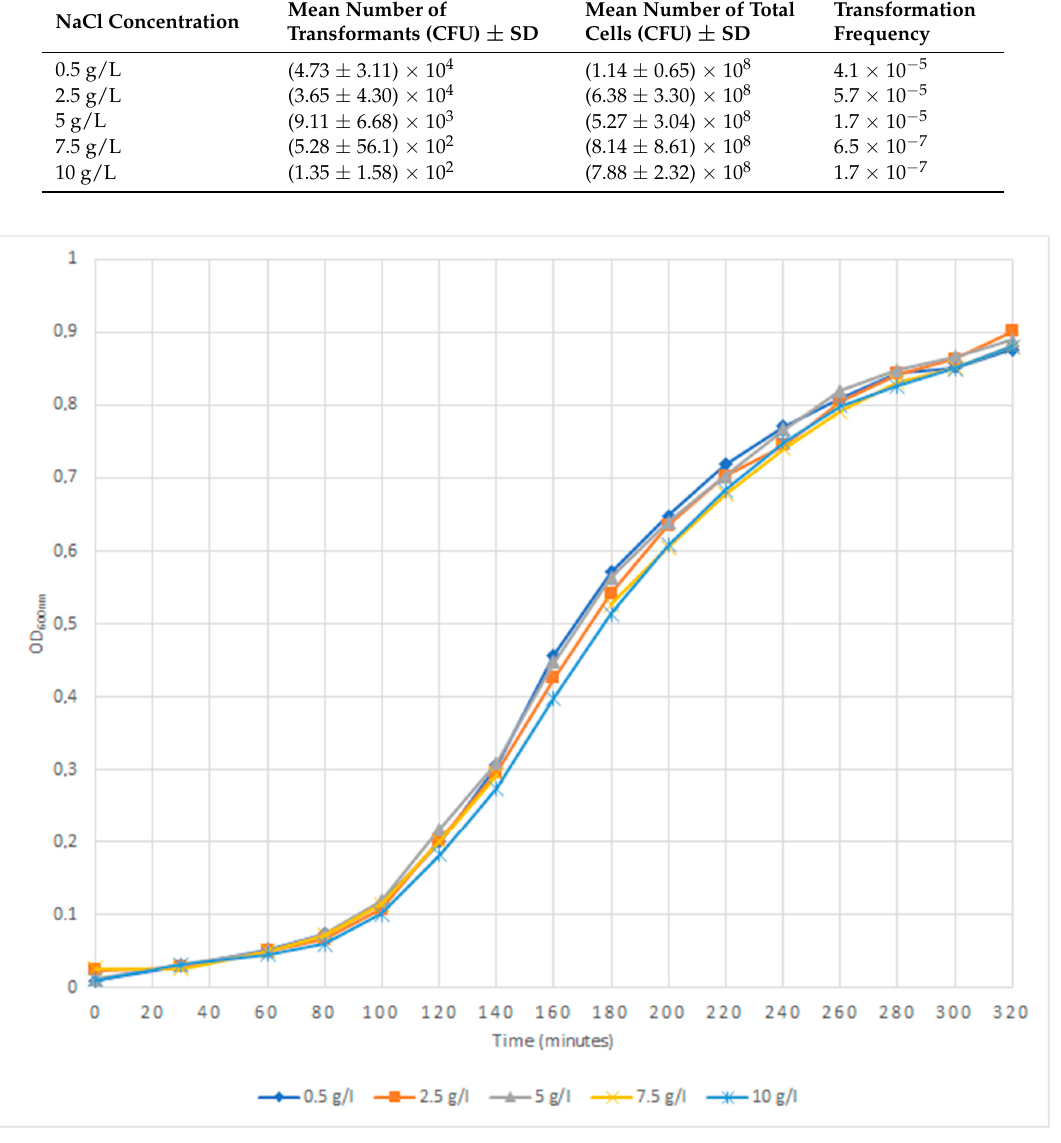
Figure 1. Effect of sodium chloride on the growth of Acinetobacter baumannii